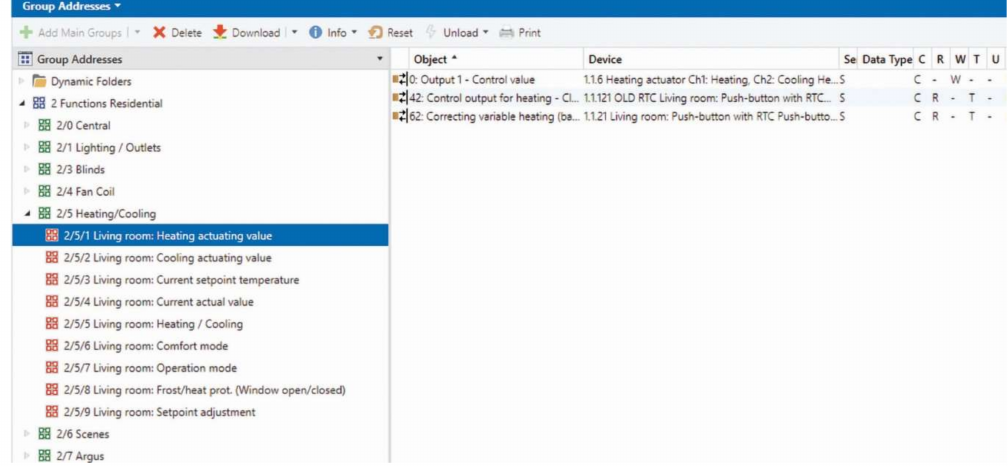
Figure 3. Group address structure created to simulate the management of operational and technical functions in the Engineering Tool Software (ETS)